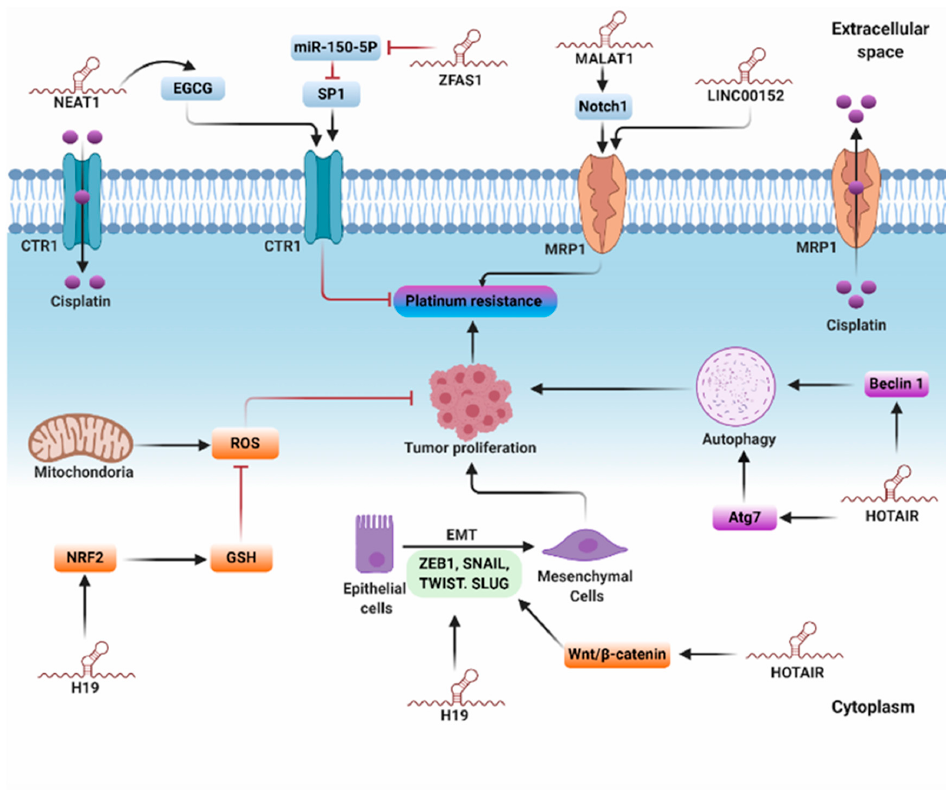
Figure 3. Molecular mechanisms of lncRNAs involved in platinum resistance. The lncRNA ZFAS1 enhances cisplatin resistance through regulating the miR-150-5p/SP1/copper transporter 1 (CTR1) axis. Nuclear-enriched abundant transcript 1 (NEAT1) ameliorates platinum resistance via upregulating epigallocatechin-3-gallate (EGCG)-induced CTR1 expression. Metastasis-associated lung adenocarcinoma transcript 1 ( MALAT1) and LINC00152 promote cisplatin resistance through